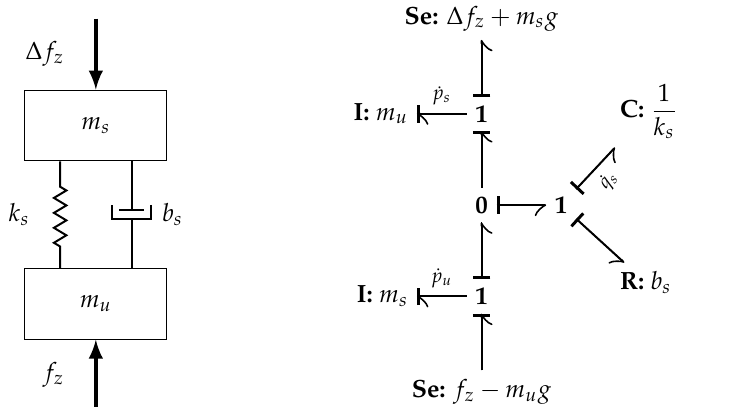
Figure 2. Quarter-car model of the suspension with wheel normal force and load transfer as